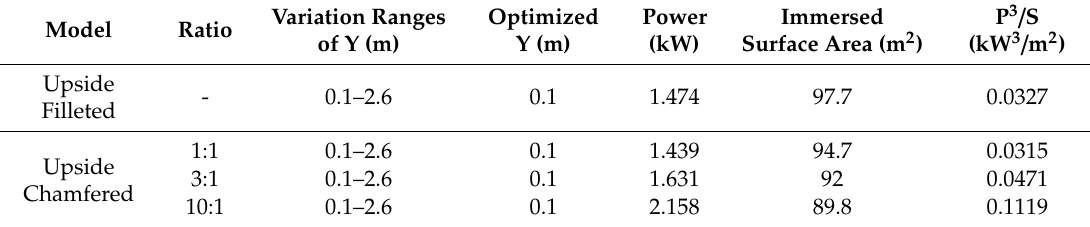
Table 6. The optimized results for the bottom chamfered shape.